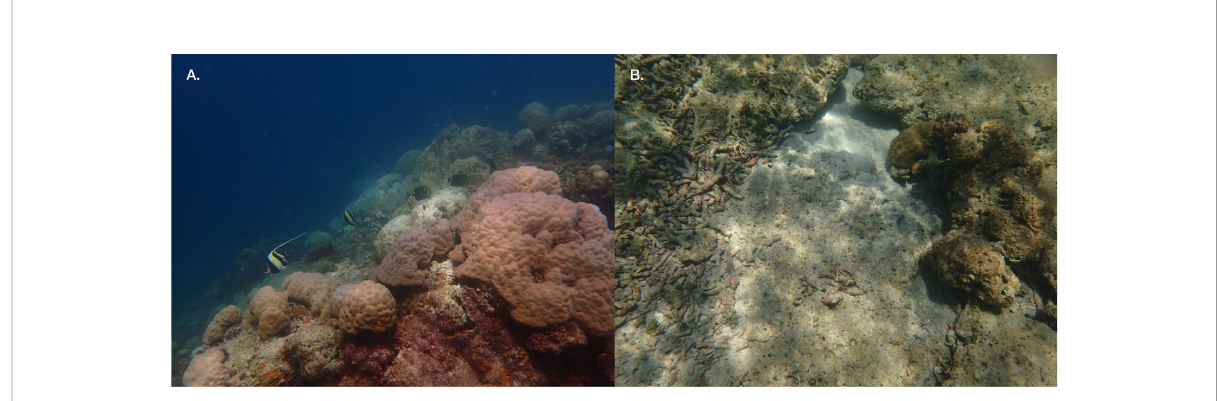
FIGURE 10 Images of fl at-top patch reefs. (A) Colonies of massive coral Porites on the edges of fl at-top patch reefs in the Dongsha Atoll lagoon. (B) Lack of corals in the central part of a fl at-top patch